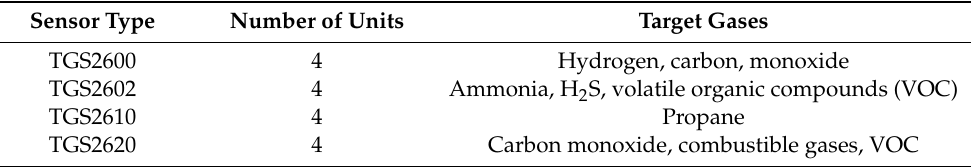
Table 1. Sensors Information in the Sensor